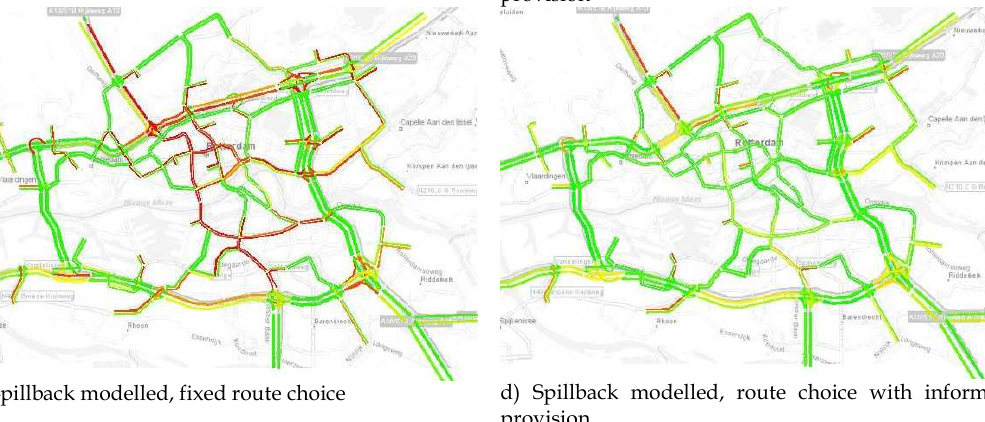
Figure 6. The impact of closure a link. The colour of a link indicates its impact: delays are large when there is a closure on a red link; delays are minor if there is a closure on a green